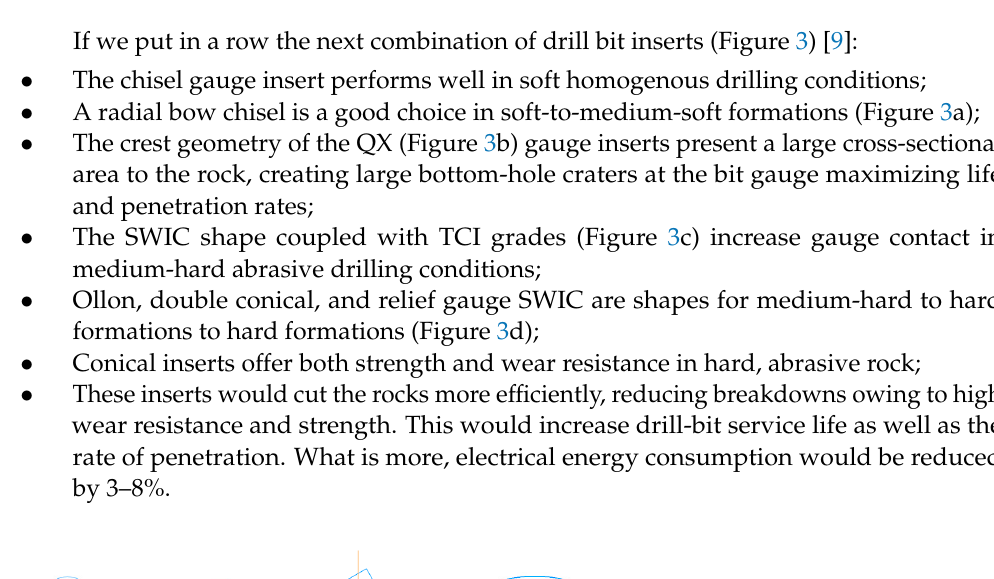
Figure 2. Drill bit design.